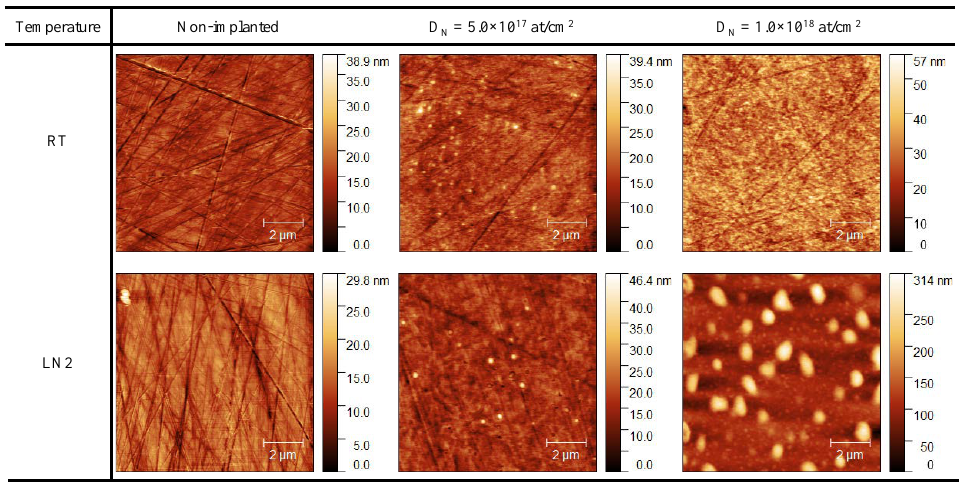
Figure 4. AFM topographic images of the non-implanted and nitrogen implanted die steel samples with nominal fluences of 5.0 × 10 17 at/cm 2 and 1.0 × 10 18 at/cm 2 for both room and LN